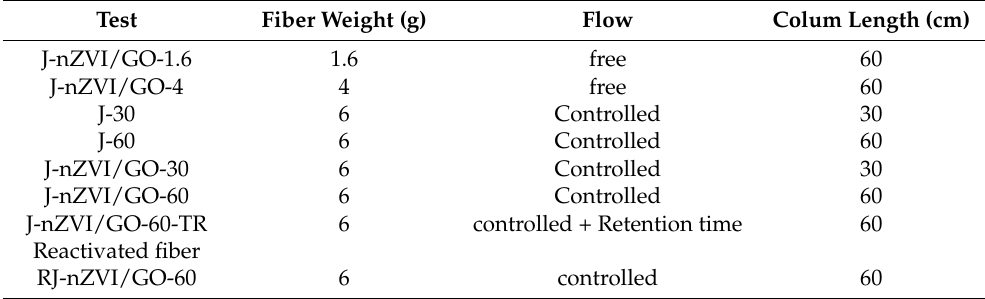
Table 1. Test parameters.